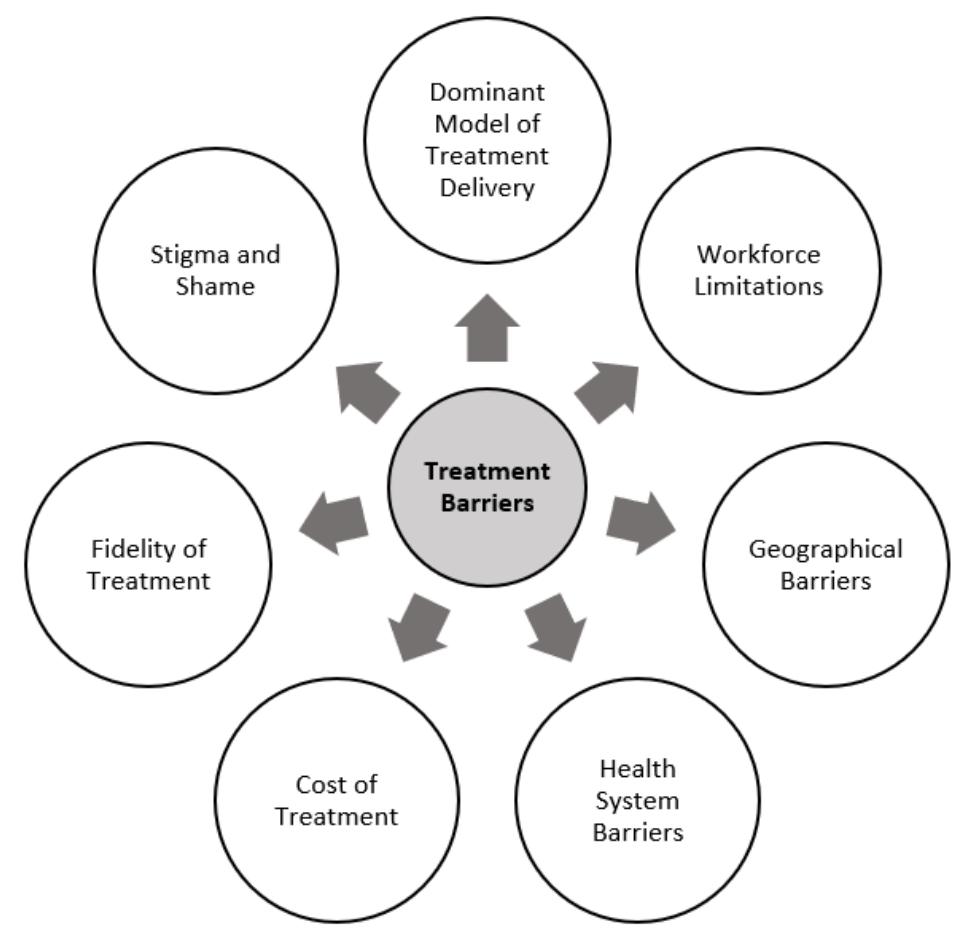
Figure 1. Barriers to treatment access for individuals with bulimia nervosa .